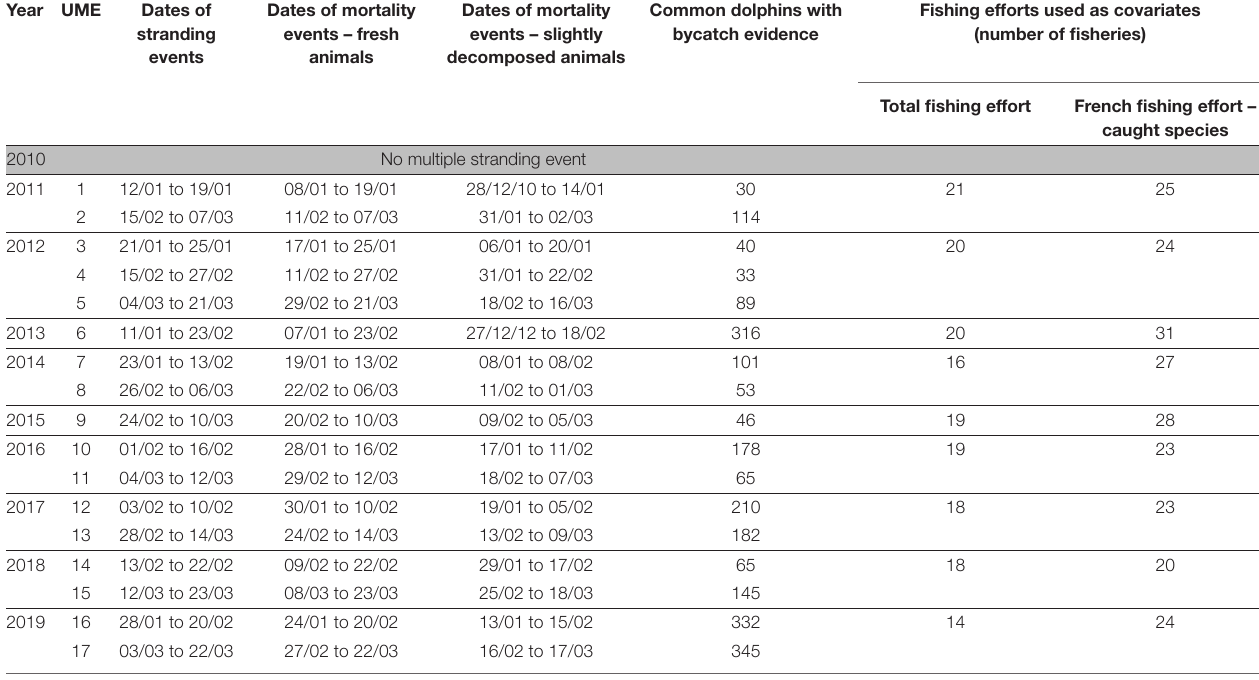
TABLE 4 | Details of unusual mortality events (UMEs) used to identify correlations with fishing